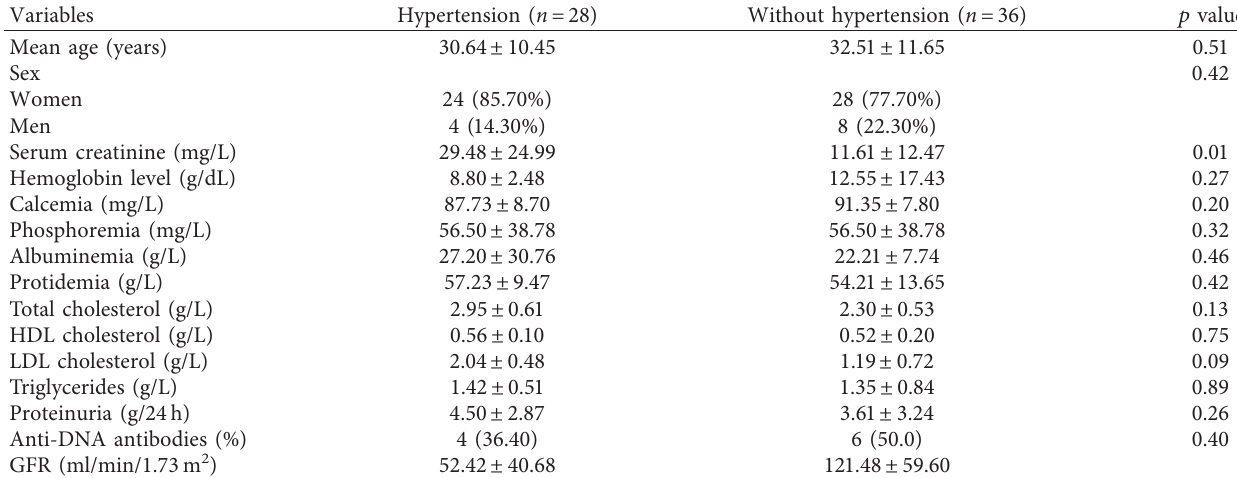
Table 1: Comparison of socio-demographic, clinical characteristics of cases and controls.